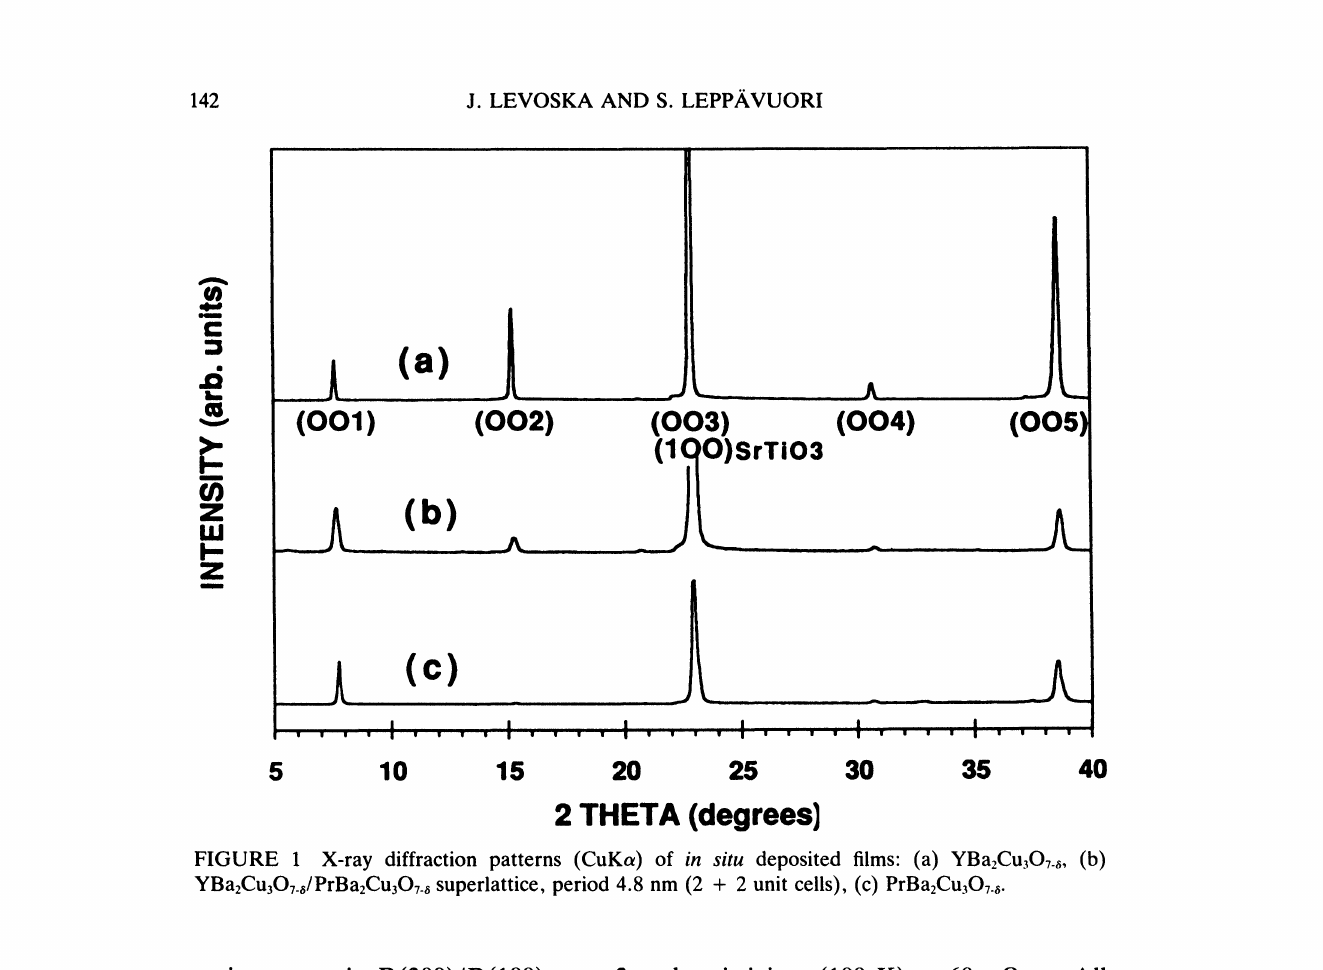
FIGURE X-ray diffraction patterns (CuKa) of in situ deposited films: (a) YBa2fu3OT., (b) YBa2Cu3OT_/PrBa2Cu3OT_ superlattice, period 4.8 nm (2 + 2 unit cells), (c) PrBa2Cu3OT.. resistance ratio R(300)/R(100) near 3 and resistivity p(100 K) 60 lcm.